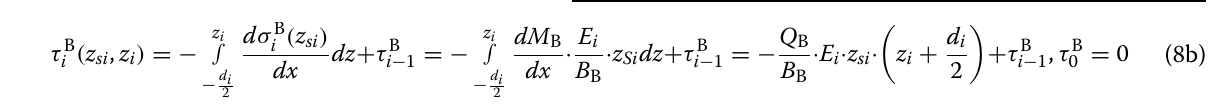
A σ B the i th layer; σ i , i are the normal stress and the shear stress in i th layer derived from beams A and B, respectively. Normal and shear stress calculated from